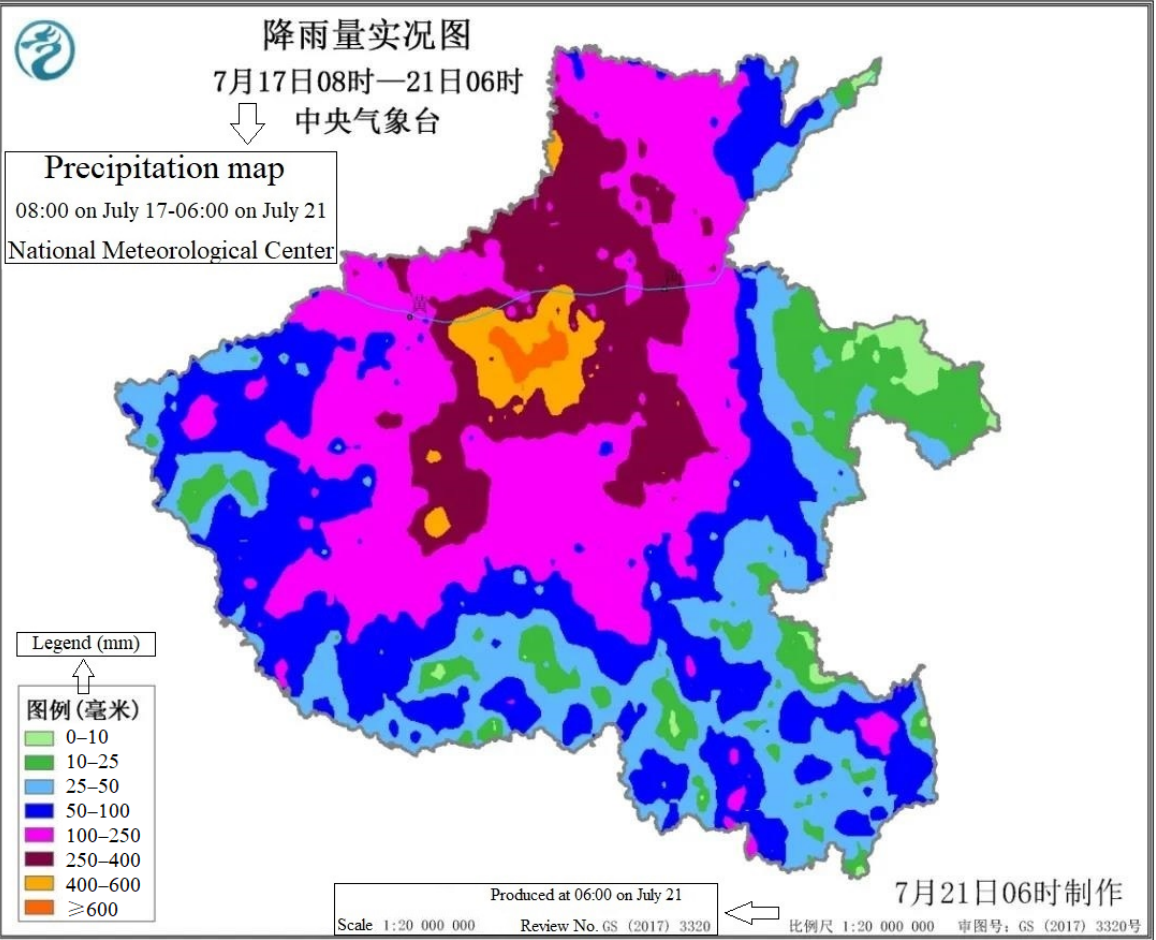
Figure 1. The precipitation map from 8:00 on July 17 to 6:00 on July 21 (redrawn from [7]).